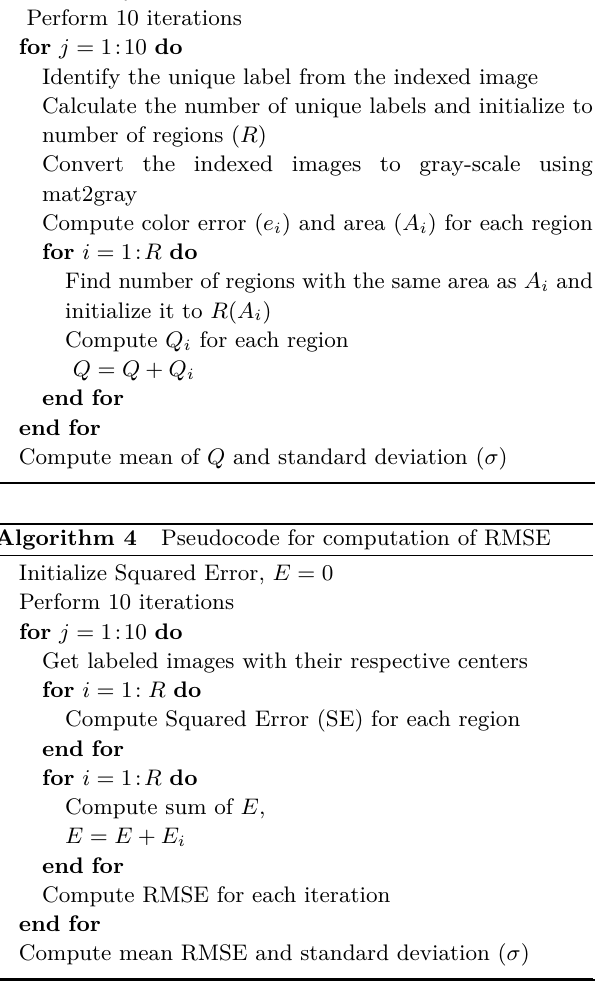
Algorithm 3 Pseudocode for mean Q values and standard deviation